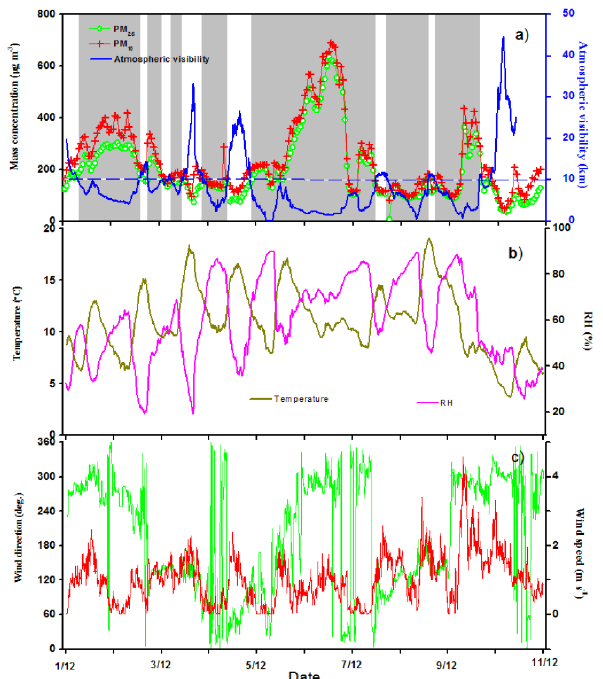
Figure 1. (a) Temporal variations of PM 2 . 5 , PM 10 and atmospheric visibility (vis) measured in Shanghai from 1 to 10 December 2013. The dashed line is visible at 10km. (b, c) show temporal variations of meteorological parameters from 1 to 10 December 2013.